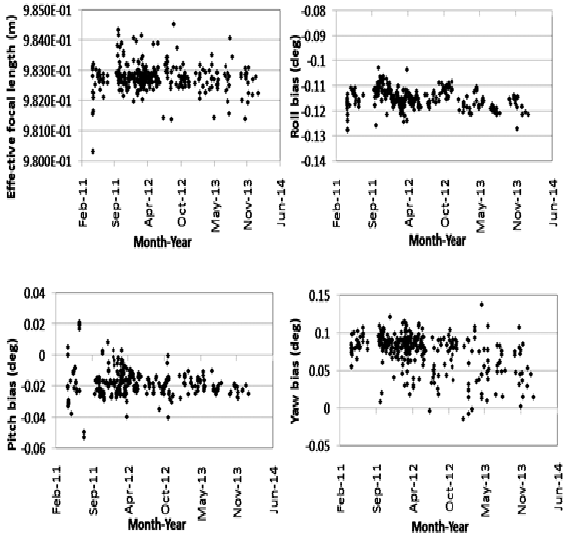
Figure 8 Payload alignment angles and Effective focal length computed for L4 datasets